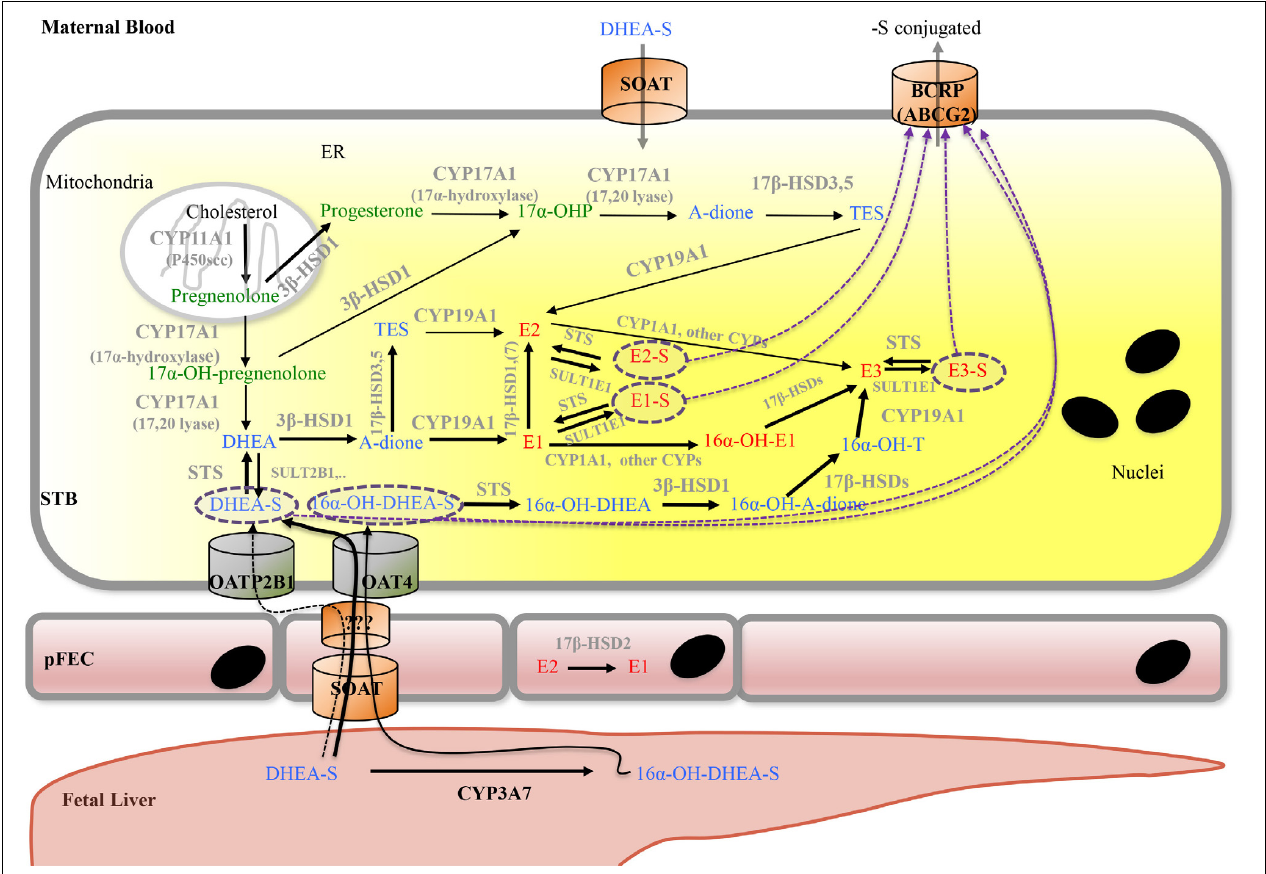
FIGURE 6 | Proposed model for placental progesterone and estrogen synthesis. For detailed description, see text. Progestagens are shown in green, estrogens in red, and androgens in blue color. Solid arrows indicate enzymatic steps that have been demonstrated in human placenta; respective enzymes are shown in gray. Dashed arrows indicate hypothetic routes of transport of sulfate-conjugated compounds. Dashed purple circles highlight sulfate-conjugated compounds that require transporters for uptake into (SOAT, OAT4, and OATP2B1) and export (ABCG2) from cells. A-dione, androstenedione; ABC transporters, ATP-binding cassette transporters; BCRP, breast cancer resistance protein; DHEA, dehydroepiandrosterone; DHEA-S, dehydroepiandrosterone sulfate; CYPs, cytochrome P-450 enzymes; E1, estrone; E1-S, estrone sulfate; E2, Estradiol; E2-S, estradiol sulfate; E3, estriol; E3-S, estriol sulfate; ER, endoplasmatic reticulum; pFEC, placental-fetal endothelial cell; -OH-, -Hydroxy-; 17 α -OHP, 17 α -hydroxyprogesterone; HSD, hydroxysteroid dehydrogenase; OAT4, organic anion transporter 4; OATP2B1, organic anion transporting polypeptide 2B1; SOAT, sodium-dependent organic anion transporter; STS, steroid sulfatase; SULT, sulfotransferase; STB, syncytiotrophoblast; TES,